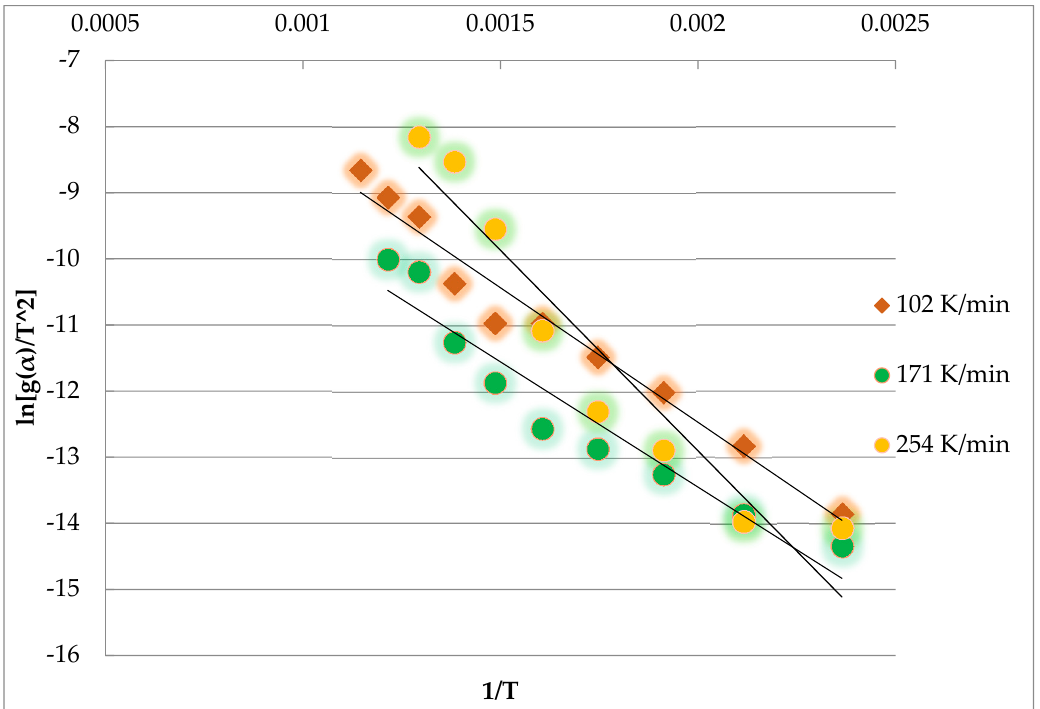
Figure 4. Simulation of kinetic model-Effect of heating rate.